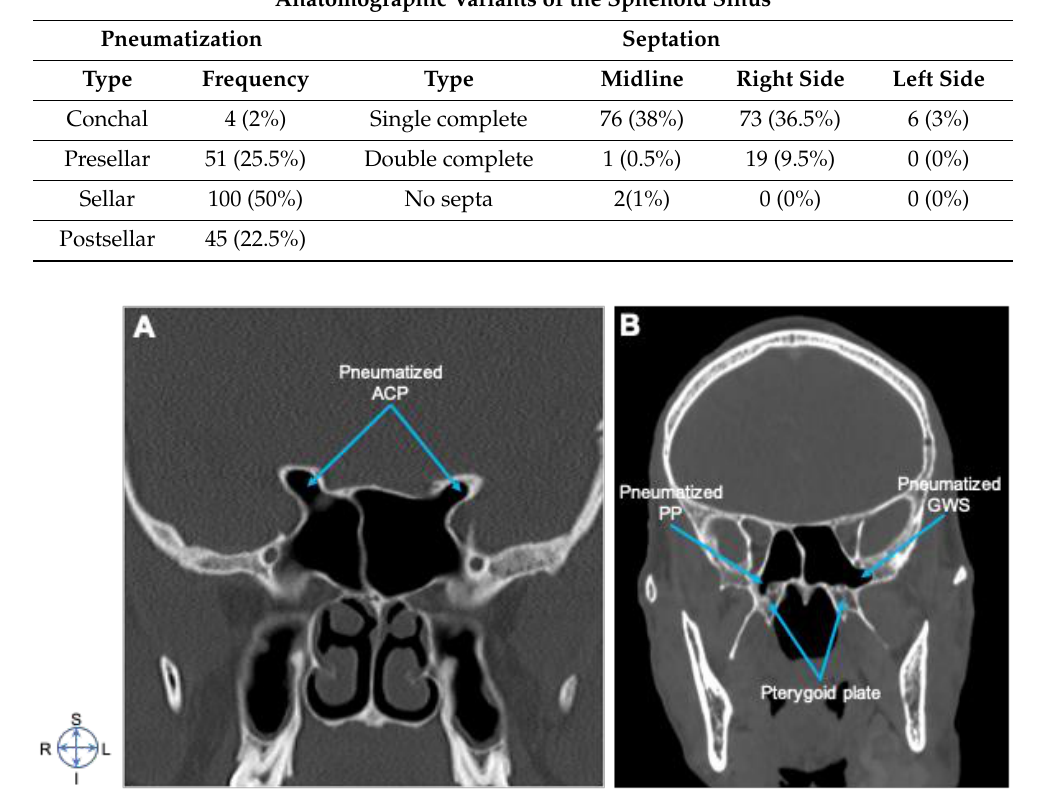
Figure 3. Pneumatization of the sphenoid sinus. Coronal CT images showing ( A ) Pneumatized anterior clinoid process (ACP); ( B ) Pneumatized pterygoid plate (PP) and greater wing of sphenoid (GWS). Note that half of the patient population participating in the study possessed sellar type of sphenoid sinus pneumatization. Image orientation: S, superior; I, inferior; R, right side; L, left side. Diagnostics 2020 , 10 , x FOR PEER REVIEW